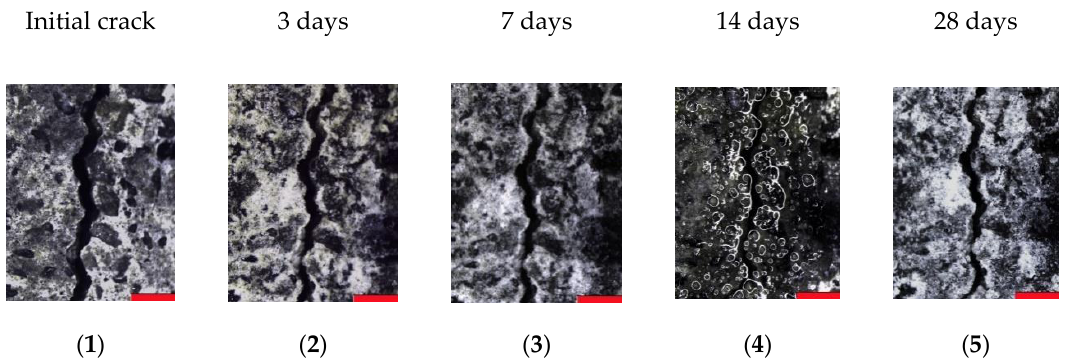
Figure 5. Evolution of crack closure as seen in microscopic images of a reference sample at ( 1 ) initial measurement and after ( 2 ) 3 days, ( 3 ) 7 days, ( 4 ) 14 days and ( 5 ) 28 days of wet-dry cycles. The scale bar at the bottom right of every micrograph represents 500 µm.